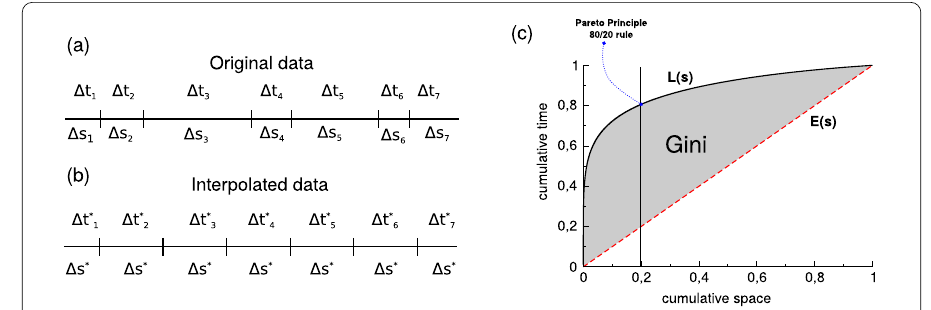
Figure 1 Model and processing of bus travel data. ( a ) Conceptual representation of the trajectories of a trip performed by a bus. On the route, in relation to the original data, the variation of time ( (cid:2) t ) and distance ( (cid:2) s ) between each consecutive GPS point is illustrated. ( b ) The same path in ( a ) is shown, however, it is divided into constant lengths ( (cid:2) s ∗ ) and the new time values ( (cid:2) t ∗ ) between each constant length are calculated from a linear interpolation. ( c ) The Lorenz curve L ( s ) generated artificially to follows the Pareto Principle is illustrated. This curve is constructed by performing the cumulative sum of the constant distances ( (cid:2) s ∗ ) all divided by total length on the x -axis. On the y -axis we have the cumulative sum of the descending order time values ( (cid:2) t ∗ ) normalized by the total time. The function y = x (dashed line) is the equality line E ( s ) and two times the area defined between the Lorenz curve and the equality line is numerically equal to the Gini coefficient. The Gini value accounts for the heterogeneity of travel times distribution. The continuous vertical line points to the 80/20 ratio of the Pareto